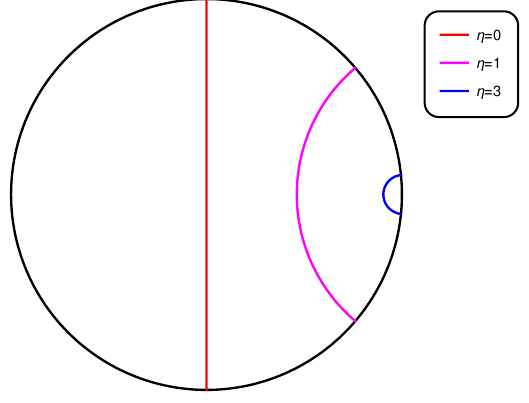
Figure 3: The Rindler regions corresponding to different values of the boost parameter η